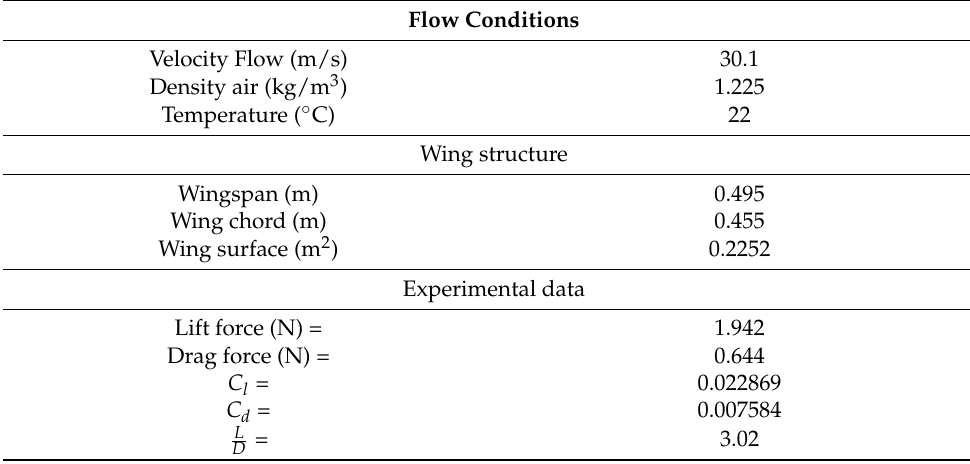
Table 8. Aerodynamic parameters of the S45 reference wing.